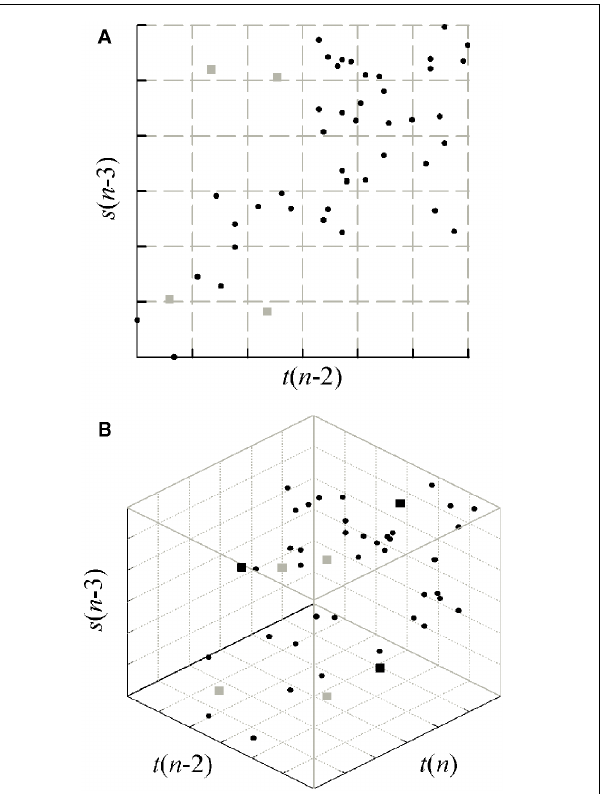
FIGURE 4 | Example of space partitioning for CE computation at the step k = 2 of Figure 3A (first repetition of the procedure). (A) To compute H ( V 2 ), all values assumed by the vector V 2 = [ t ( n − 2), s ( n − 3)] are assigned to hypercubes resulting from uniform quantization of the two coordinates (gray grid); then, the entropy is computed as H ( V 2 ) =− Σ p ( V 2 )·log p ( V 2 ). (B) The analysis is repeated for all values assumed by the vector [ t ( n ), V 2 ] = [ t ( n ), t ( n − 2), s ( n − 3)] to compute H ( t ( n ), V 2 ) =− Σ p ( t ( n ),